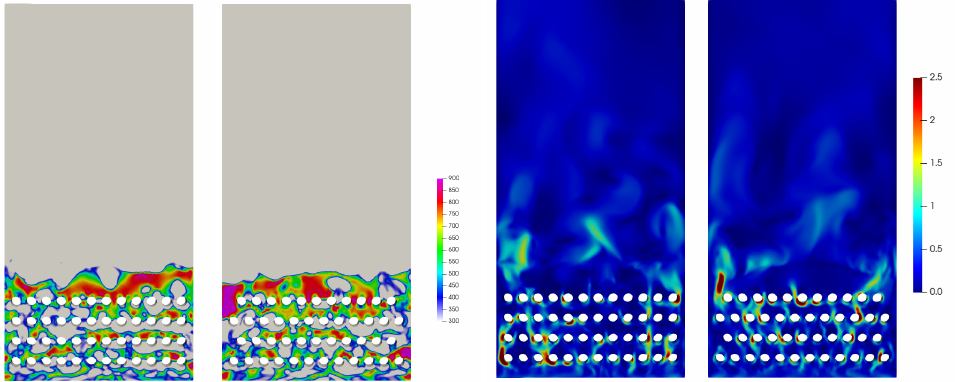
Figure 13. ( Left ): instantaneous distribution of the Nusselt number. ( Right ): instantaneous distribu- tion of gas